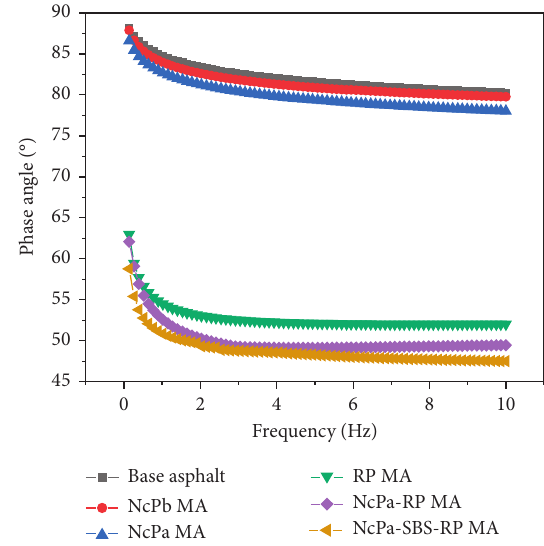
Figure 10: Phase angle versus frequency.